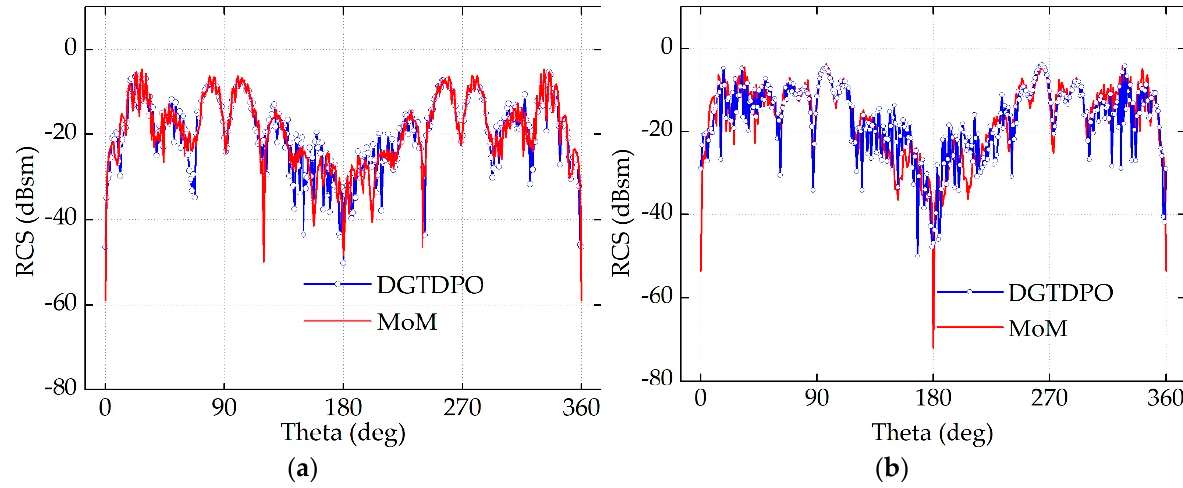
Figure 11. The RCS of a multi-scale object above a plate computed at ( a ) 1 GHz and ( b ) 1.5 GHz from the solutions of the DGTDPO method and MoM.